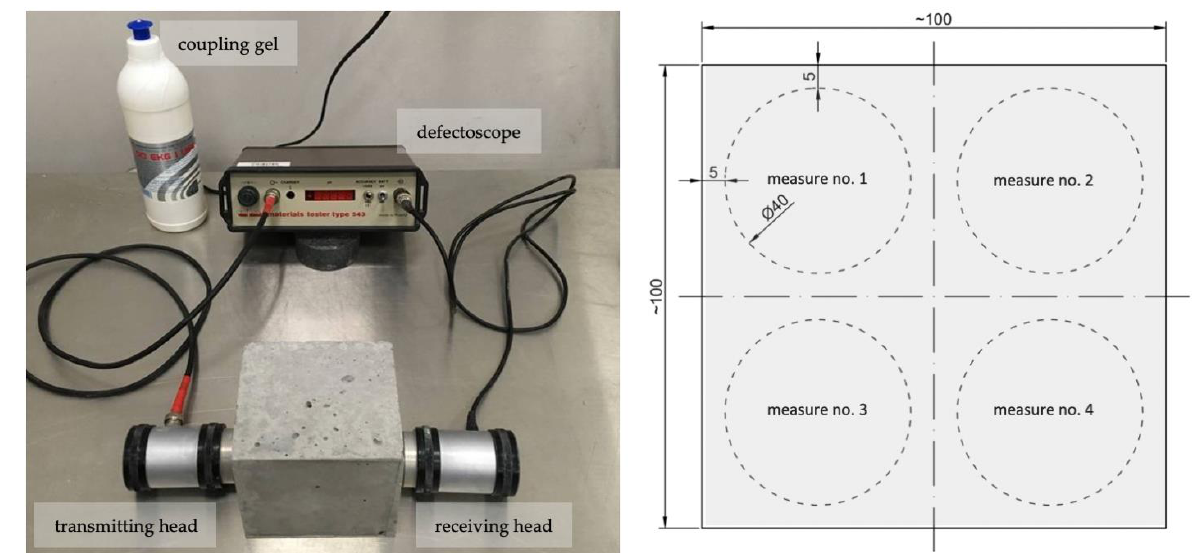
Figure 2. Test stand for ultrasonic wave velocity measurements in concrete specimens and a scheme of transducer head locations on the sample surface (dimensions in mm).